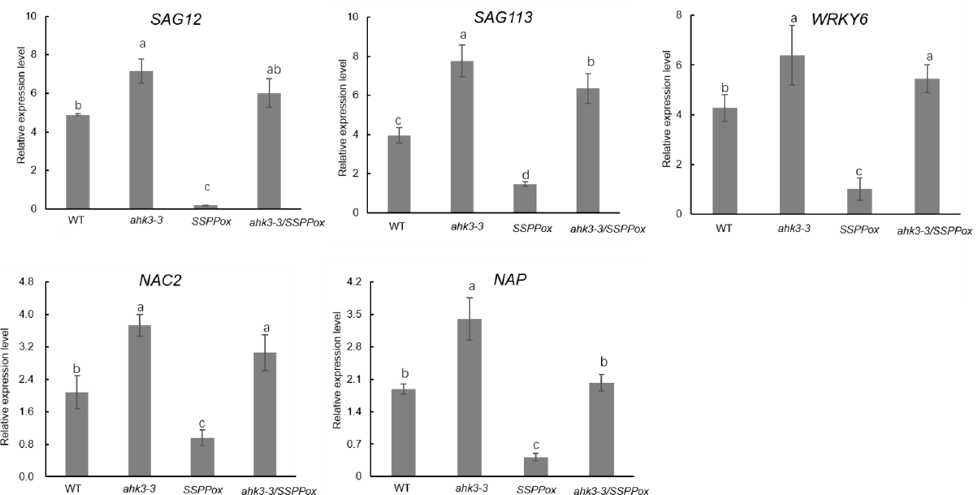
Figure 2. Knockout of AHK3 increased the transcripts levels of several critical senescence-associated marker genes in 35S:SSPP transgenic Arabidopsis. The relative expression levels of several senescence-associated marker genes were determined in ahk3-3 , SSPPox , ahk3-3 / SSPPox , and wild-type control Arabidopsis. RNA was extracted from the fifth and sixth leaves of 28-day-old plants and quantitative RT-PCR was performed as described in materials and methods using the TIP41-like gene as an internal control. Three biological replicates with at least three technical repeats were done. Different letters indicate statistically significant differences based on analysis of variance (ANOVA) ( α = 0.05). Error bars represent standard errors (SE).